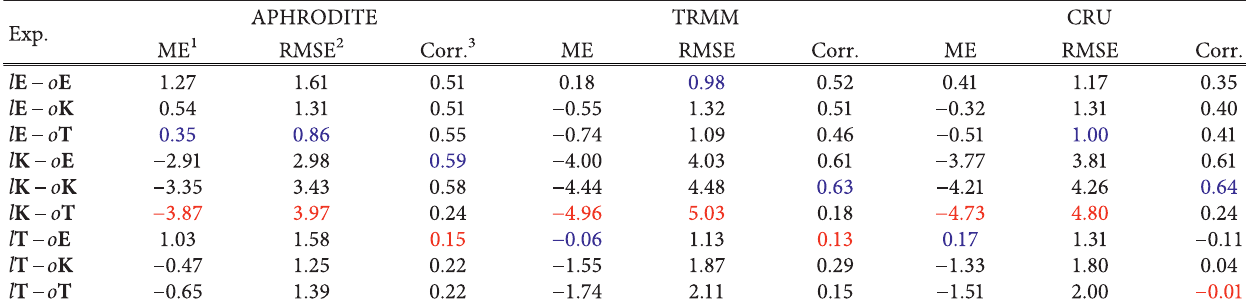
Table 3: Statistical metrics for comparison of the June-July-August-September (JJAS) mean (1998–2007) precipitation between model simulations and multiple observations. Blue and red colors indicate the best and worst performance,